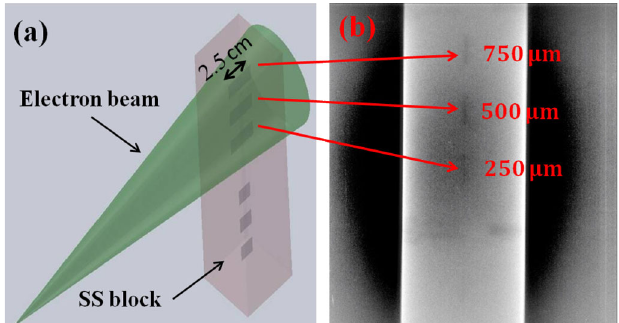
FIG. 2. (a) Three-dimensional representation of the stainless steel block with embedded voids. The electron beam used to image the voids is also shown schematically. (b) Experimental radiograph of the voids using electron beams with the character- istics shown in Fig.